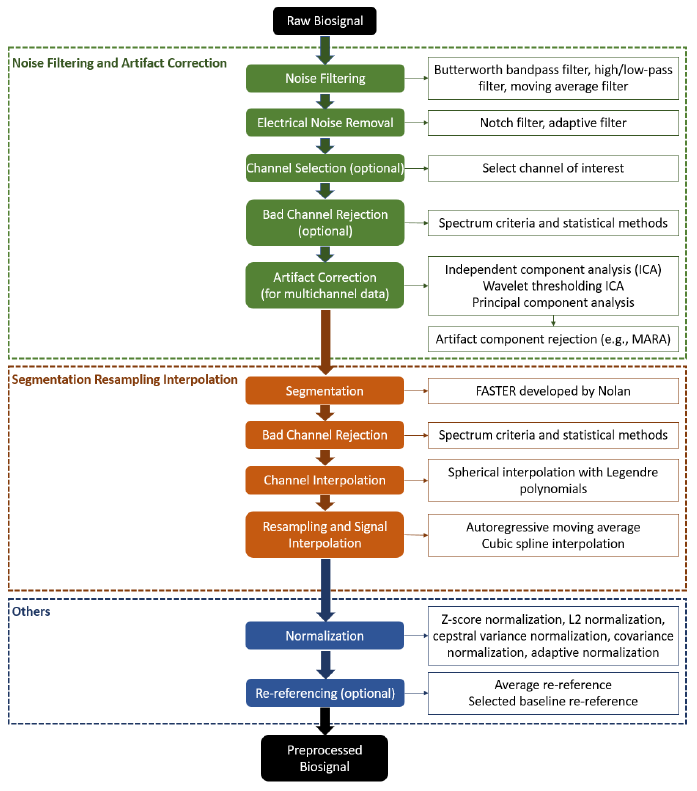
Figure 4. Biosignal pre-processing for cognitive